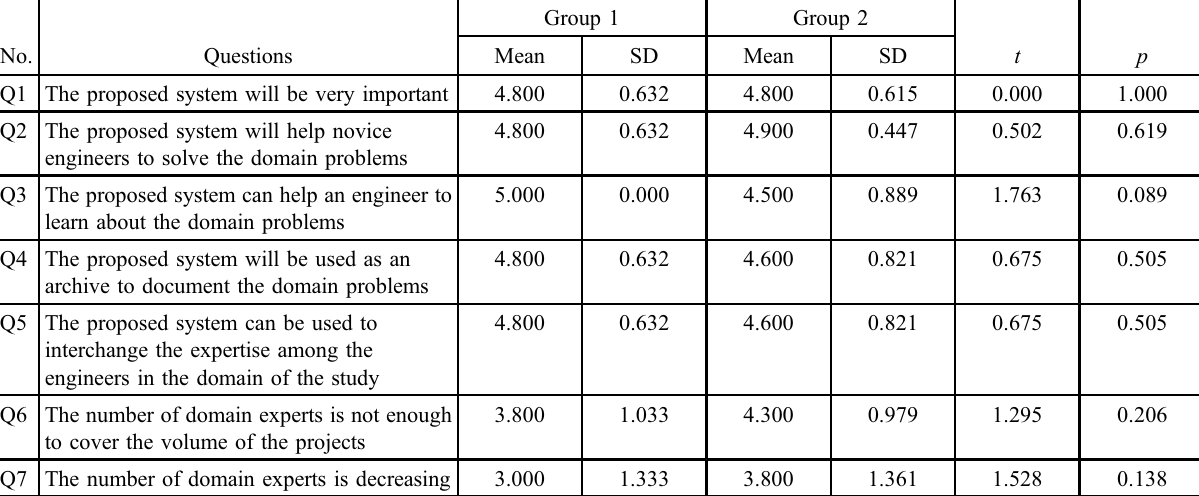
Table 2. Analysis of the questionnaire on the need for the proposed system